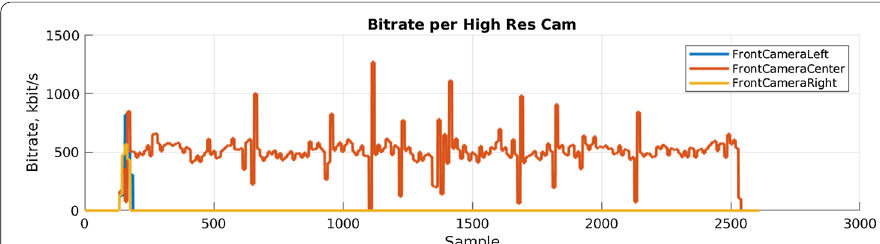
Fig. 6 Bitrates of the three front‑facing cameras on the vehicle measured in the VCoC